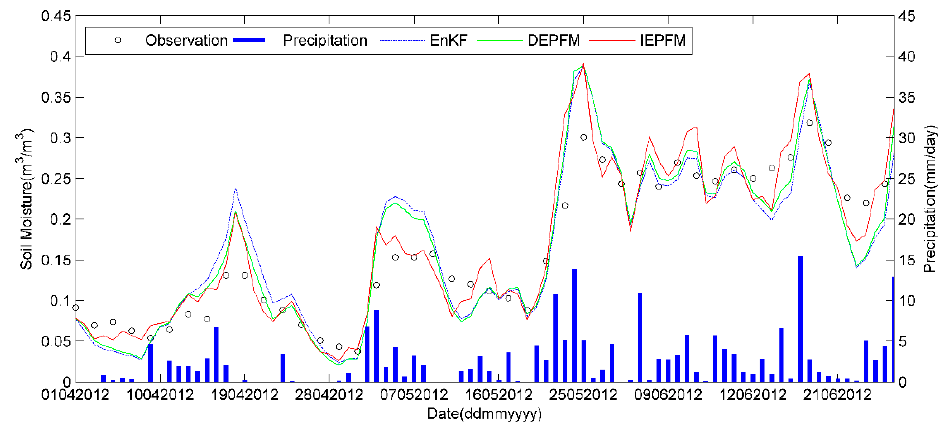
Figure 9. Comparison of the assimilation results of EnKF, DEPFM, and IEPFM with VIC model. 1.